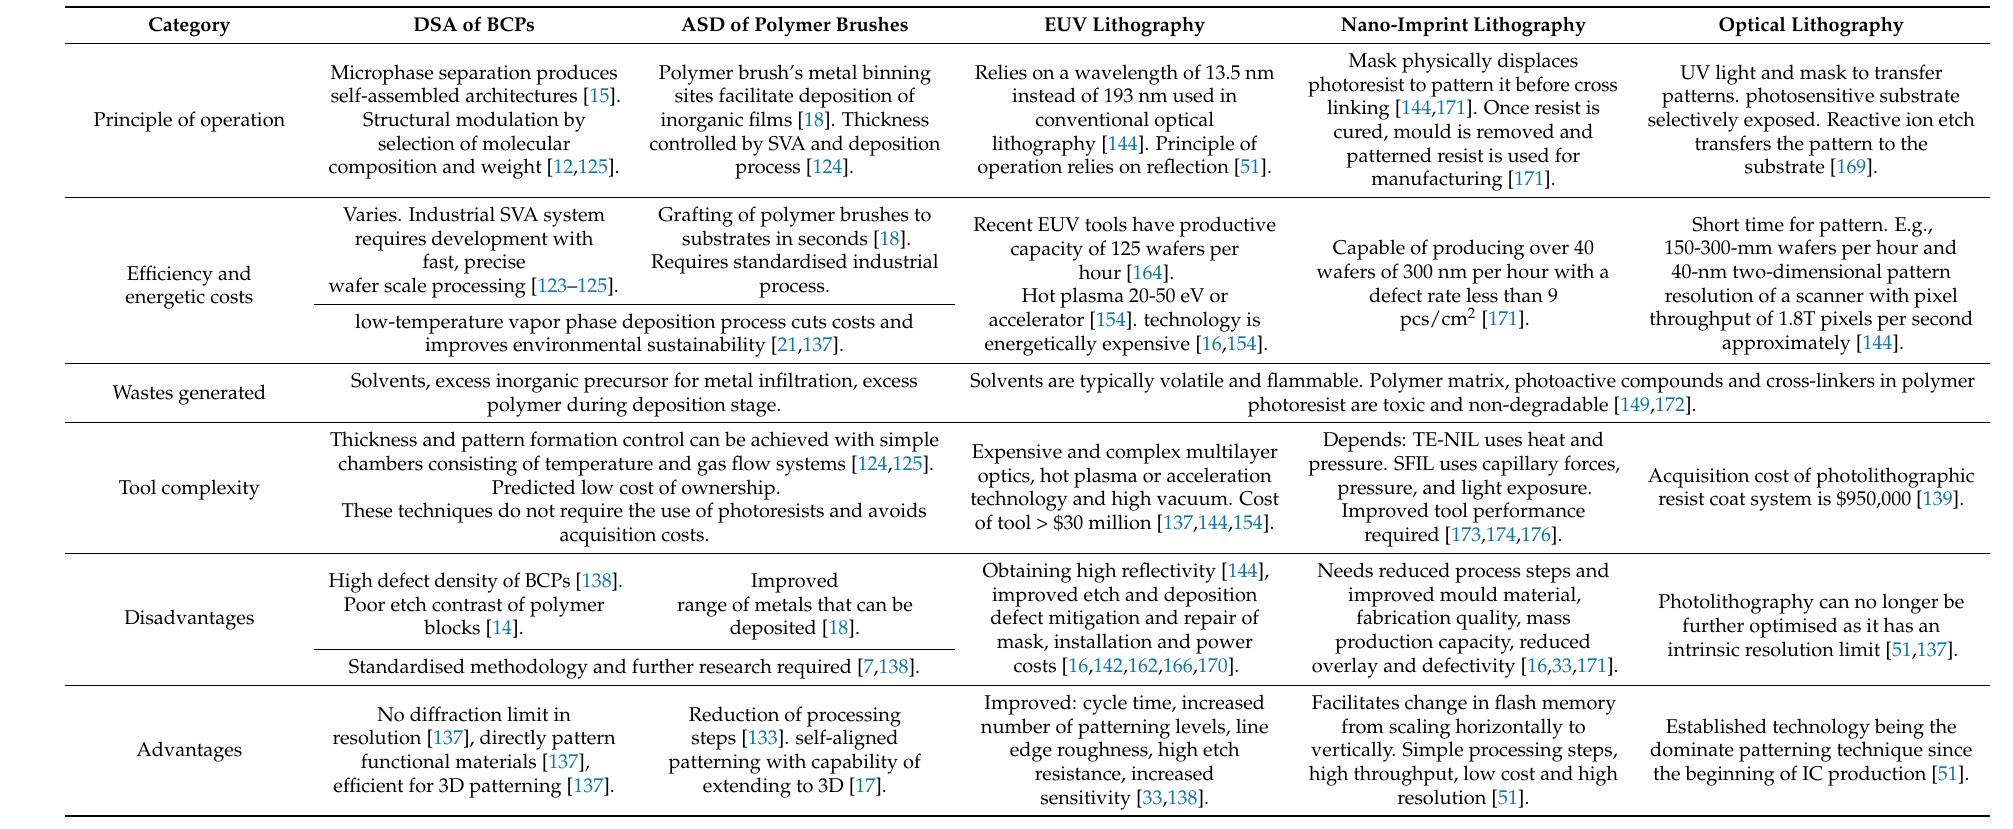
Table 1. A comparison of various lithographic